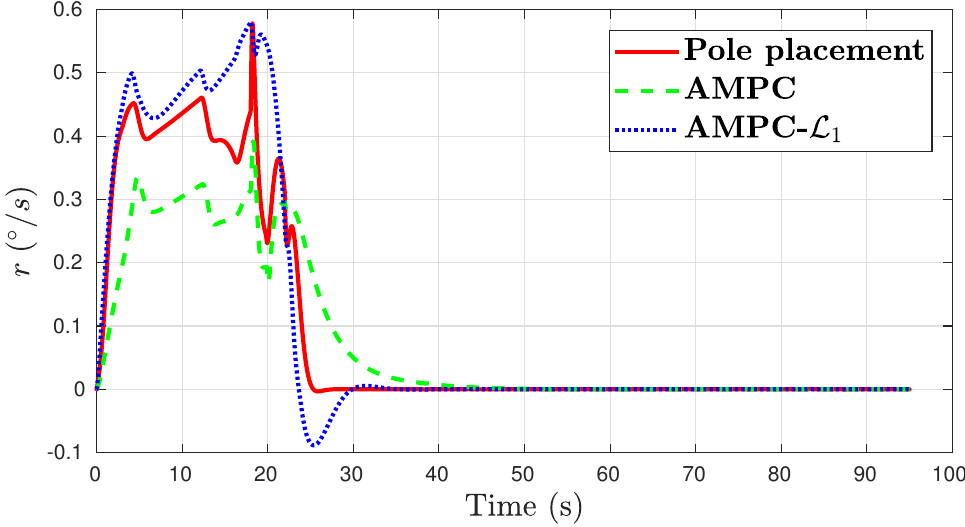
Figure 6. Yaw-rate regulation error for the nominal